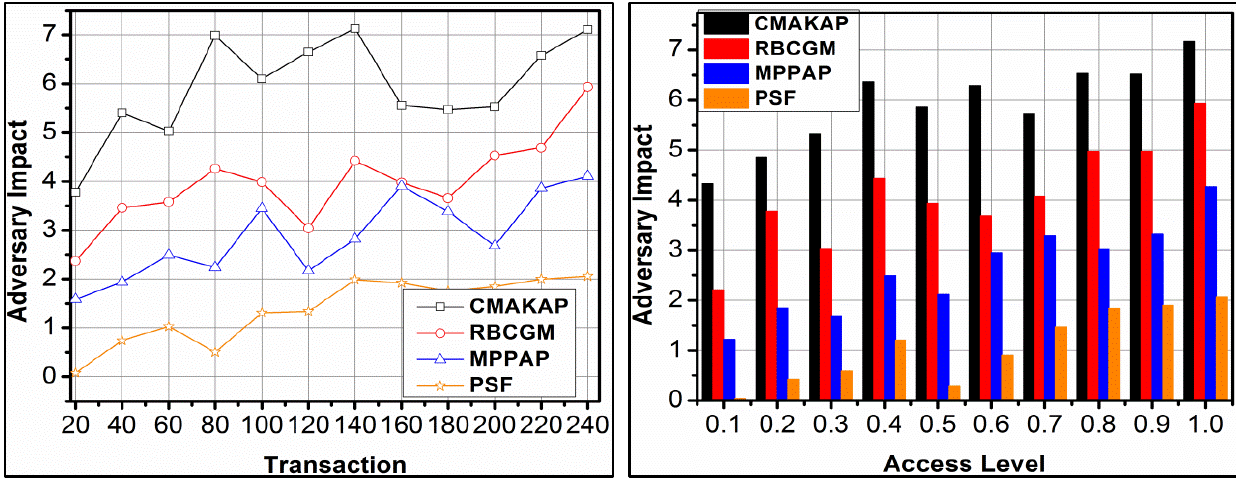
Figure 7. Adversary impact analysis.